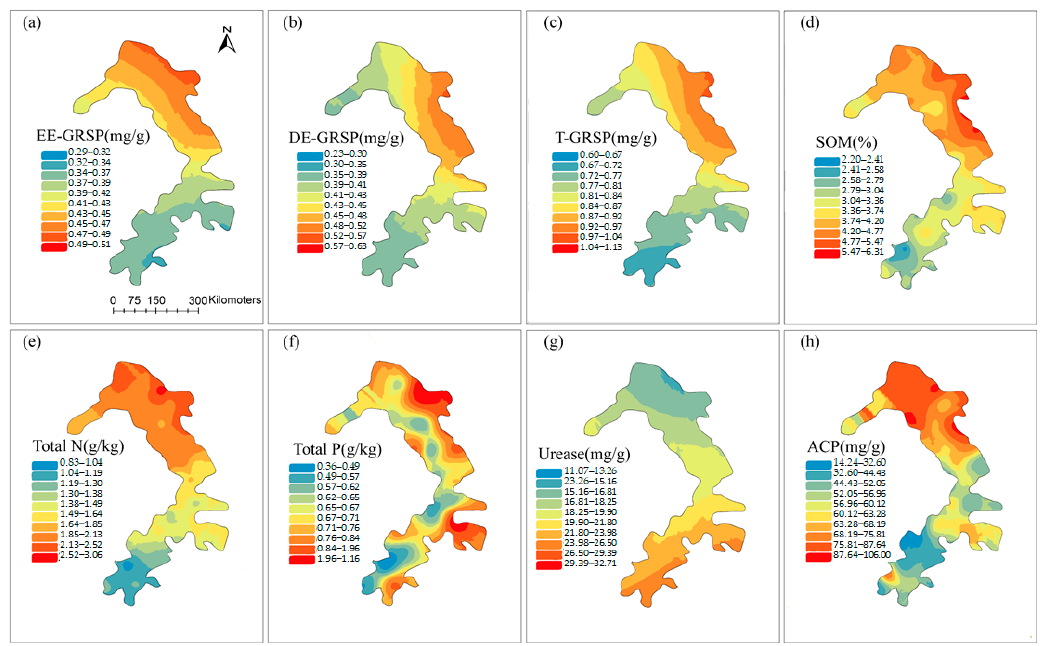
Figure 3. Spatial distribution maps of EE-GRSP (easily extractable glomalin-related soil protein, a ), DE-GRSP (difficult-to-extract GRSP, b ), T-GRSP (total GRSP, c ), SOM (soil organic matter, d ), total N ( e ), total P ( f ), urease ( g ), and ACP (acid phosphatase, h ).